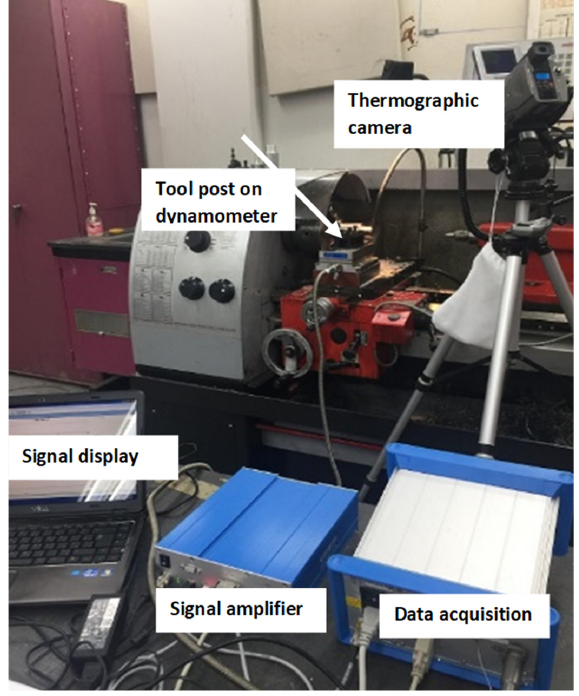
Figure 2. Test rig for machining the test pieces, evaluating the cutting forces, and measuring the cutting temperature.